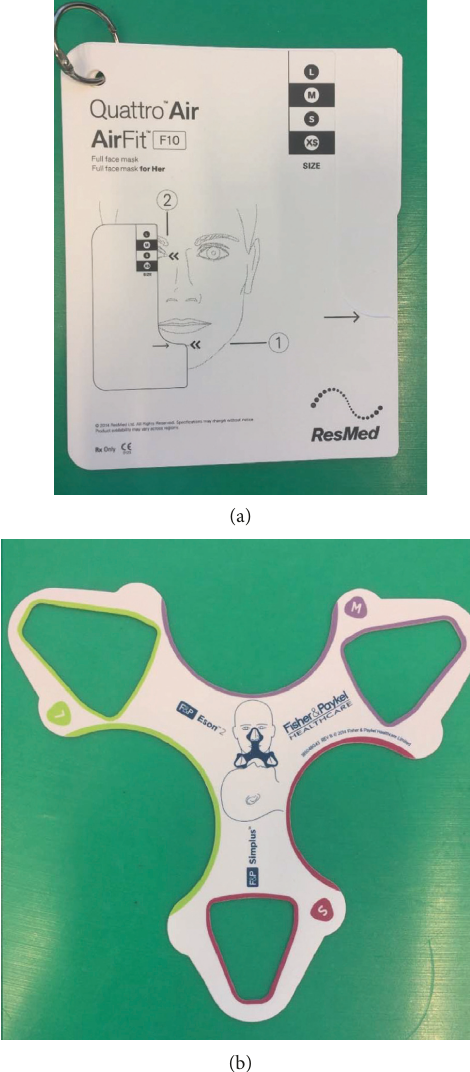
Figure 4: Tools provided by mask manufacturers to help the medical team choose a suitable mask